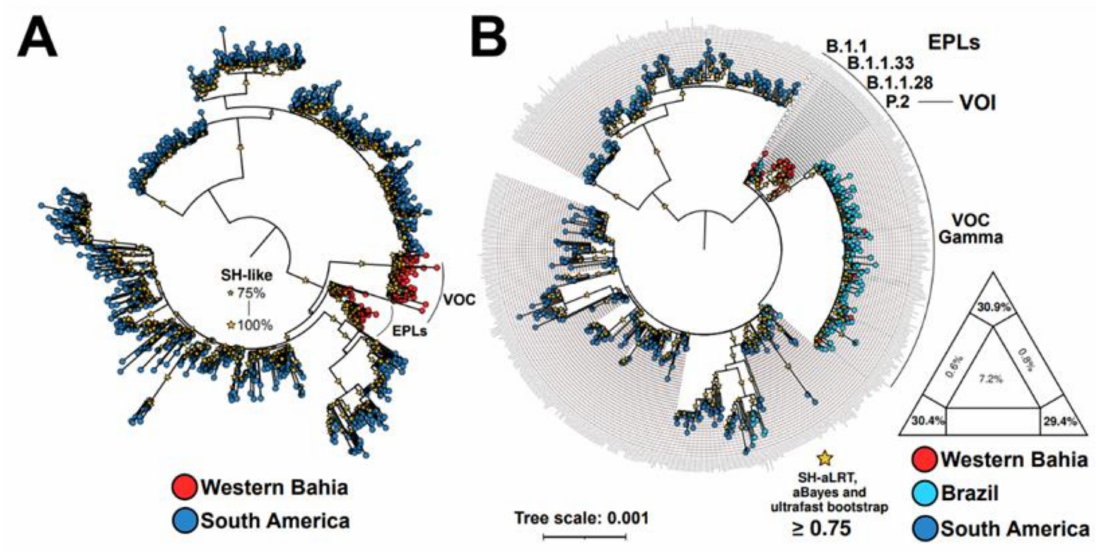
Figure 5. Maximum-likelihood midpoint rooted phylogenetic tree based on 1117 (A) and 603 ( B ) representative genome sequences of SARS-CoV-2. Nextstrain’s subsampled SARS-CoV-2 genomic data from South America (including Brazil) since pandemic started up to August 2022 containing unfiltered ( A ) and filtered ( B ) sequences from the study. The SARS-CoV-2 genomes from this study are identified by the red circles. Tips are colored according to sampling locations. Yellow stars assume Shimodaira–Hasegawa (SH-like) test ( A ) and SH-aLTR/aBayes/ultrafast bootstrap support ( B ) based on 1000 replicates. Only values equal or greater than 75% are shown. Likelihood mapping of the final sequences alignment showing low phylogenetic noise, as required for reliable phylogeny inference ( B ). Abbreviations: VOC and VOI, Variant(s) of Concern and Variant(s) of Interest, respectively. EPLs, Early Pandemic Lineages. In letter B, “Brazil” represents whole-genome of SARS-CoV-2 Gamma variant from all Brazilian States and the Federal District. Branch lengths are drawn in scale of nucleotide substitutions per site according to the bar scale. Colors and symbols used in the panels are defined according to the legend to the left and right of the